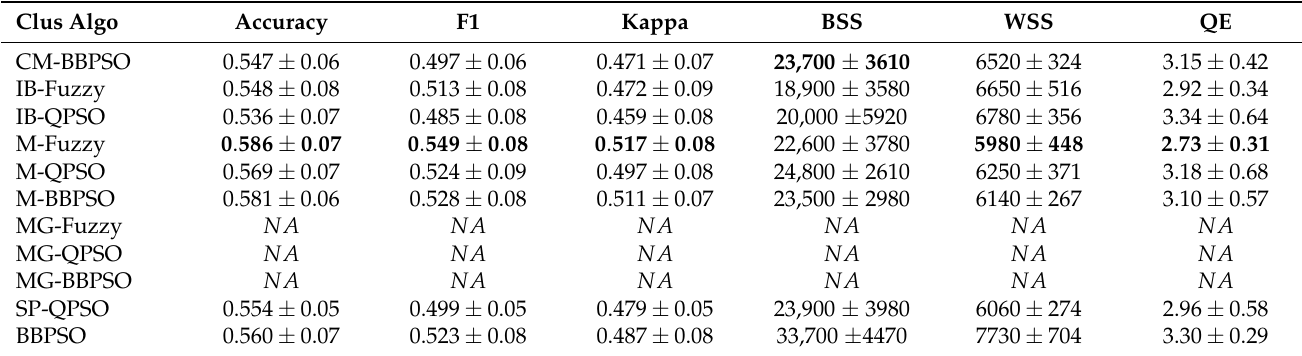
Table 3. Performance of CM-BBPSO and other clustering algorithms on Segment dataset with the best result produced by the algorithm presented in bold.